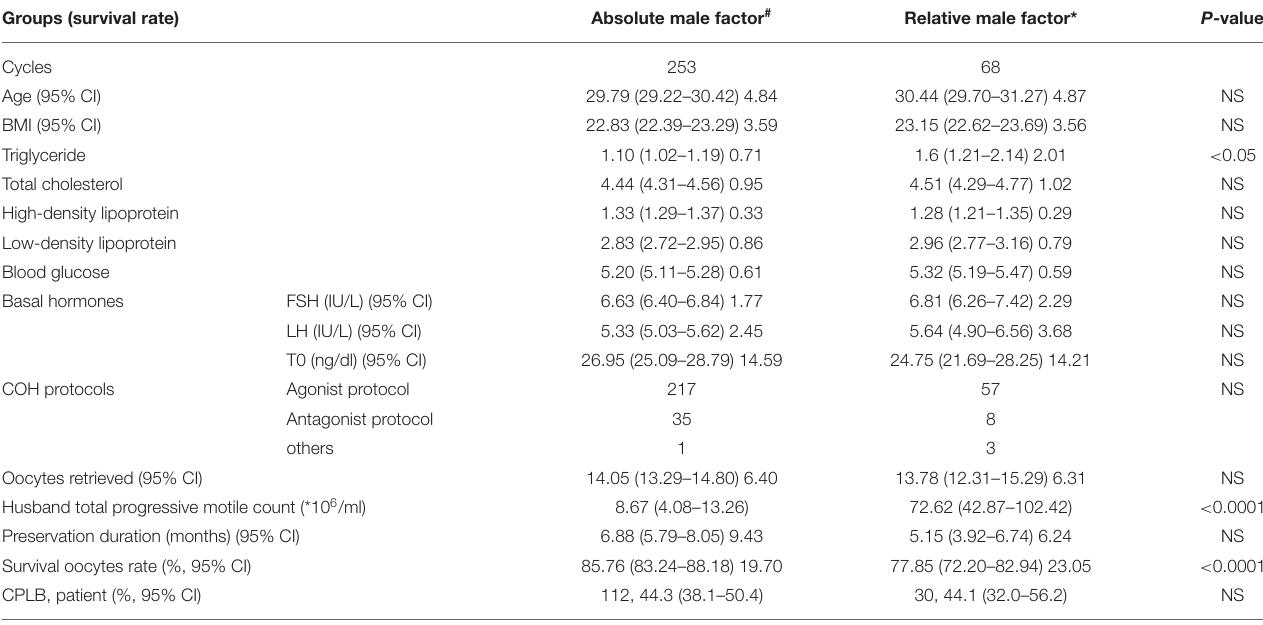
TABLE 4 | Patient and cycle characteristics and CPLB in the two oocyte vitrification groups sorted by different reasons for lack of sperm availability on oocyte retrieval day. Groups (survival rate)